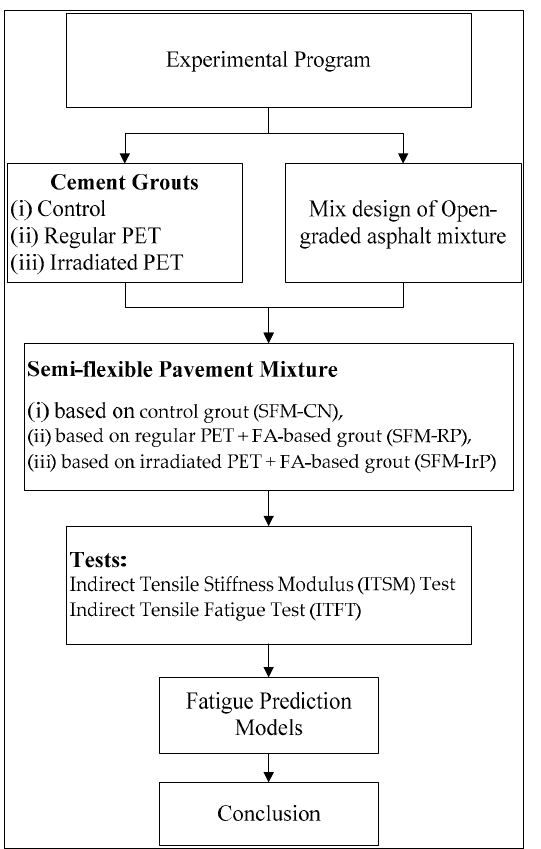
Figure 5. Methodology flow chart.